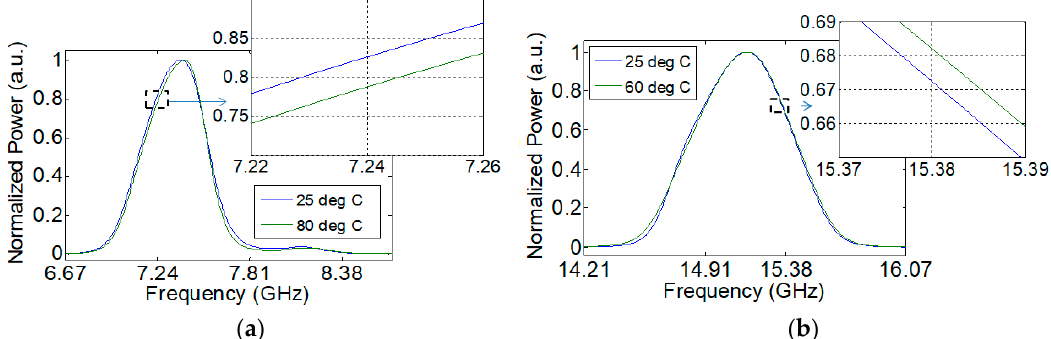
Figure 8. Illustrating simultaneous operation of the two sensors. MWP filter responses for Sensor 1 when the temperature is increased from 25 ◦ C to 80 ◦ C ( a ) and Sensor 2 when the temperature is increased from 25 ◦ C to 60 ◦ C ( b ) (after [12]).